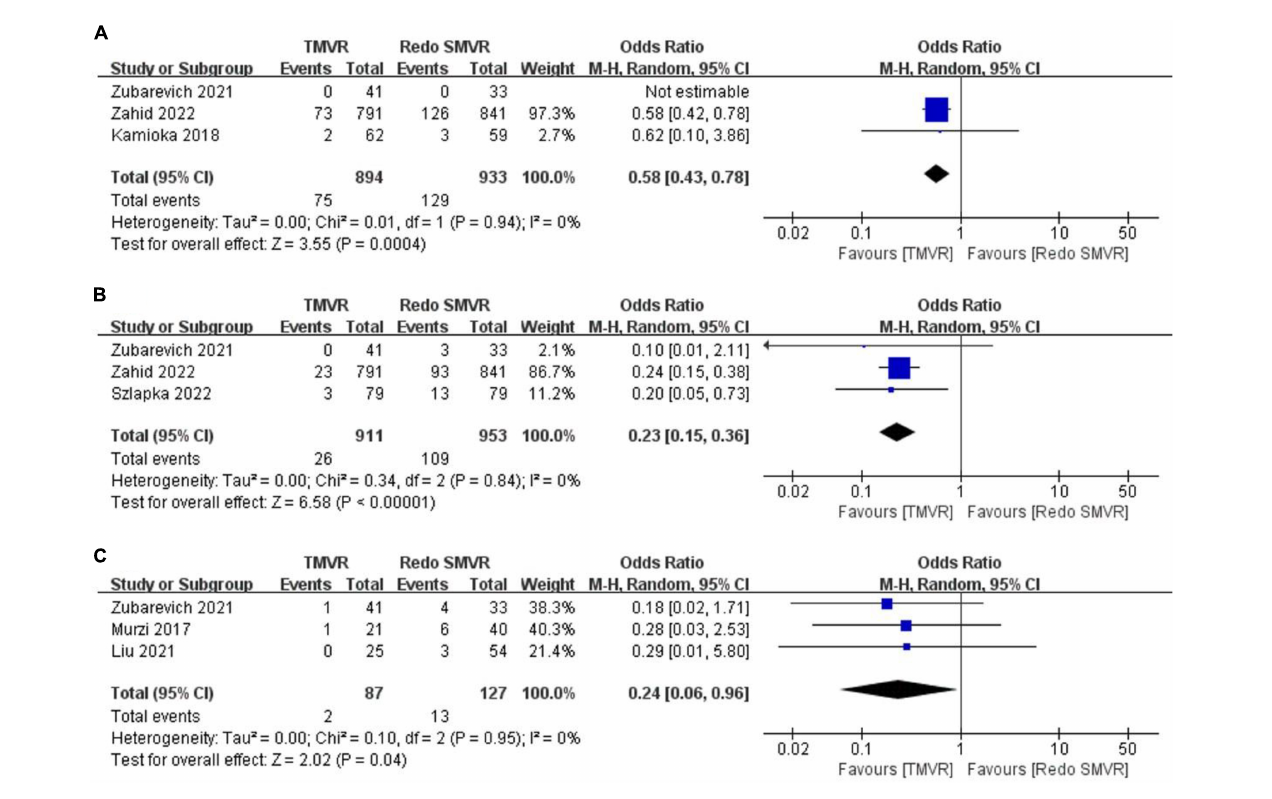
FIGURE3 Forest plot comparing TMVR with redo SMVR for (A) vascular complication, (B) pacemaker implantation, and (C) exploration for bleeding. CI, confidence interval; df, degrees of freedom; MH, Mantel–Haenszel.